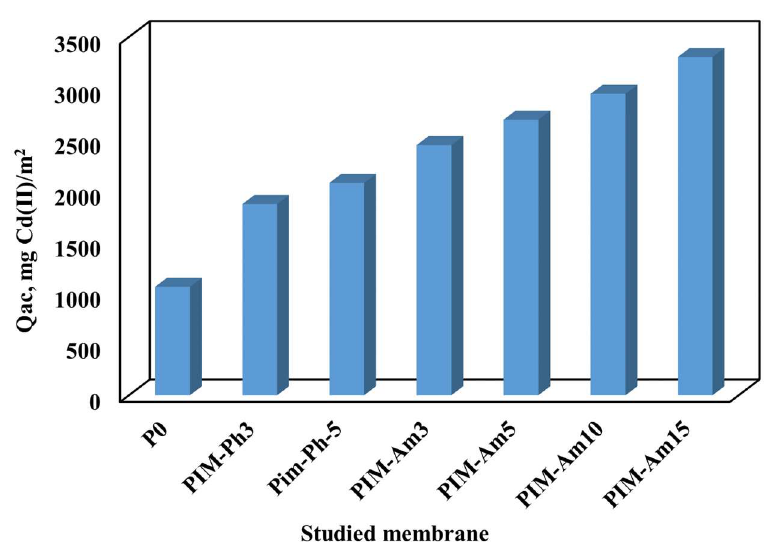
Figure 8. The filtration efficiency of the membranes studied in the treatment process of water with Cd(II) ion content.